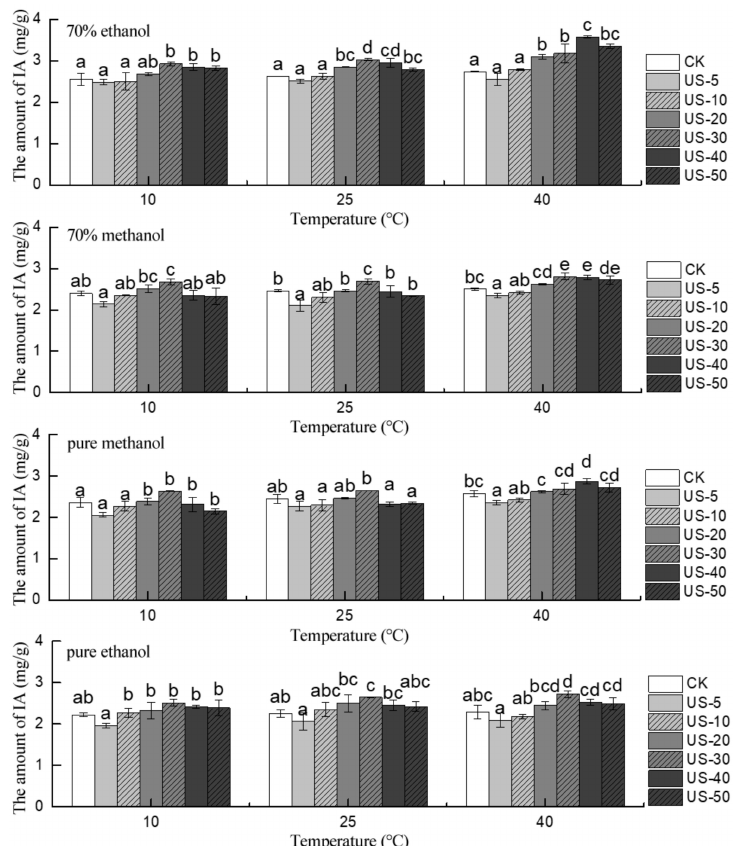
Figure 2. E ff ect of time on the stability of individual anthocyanin in blueberry pomace under ultrasound treatment and conventional solvent extraction. Di ff erent letters on bars show significant di ff erences ( p <